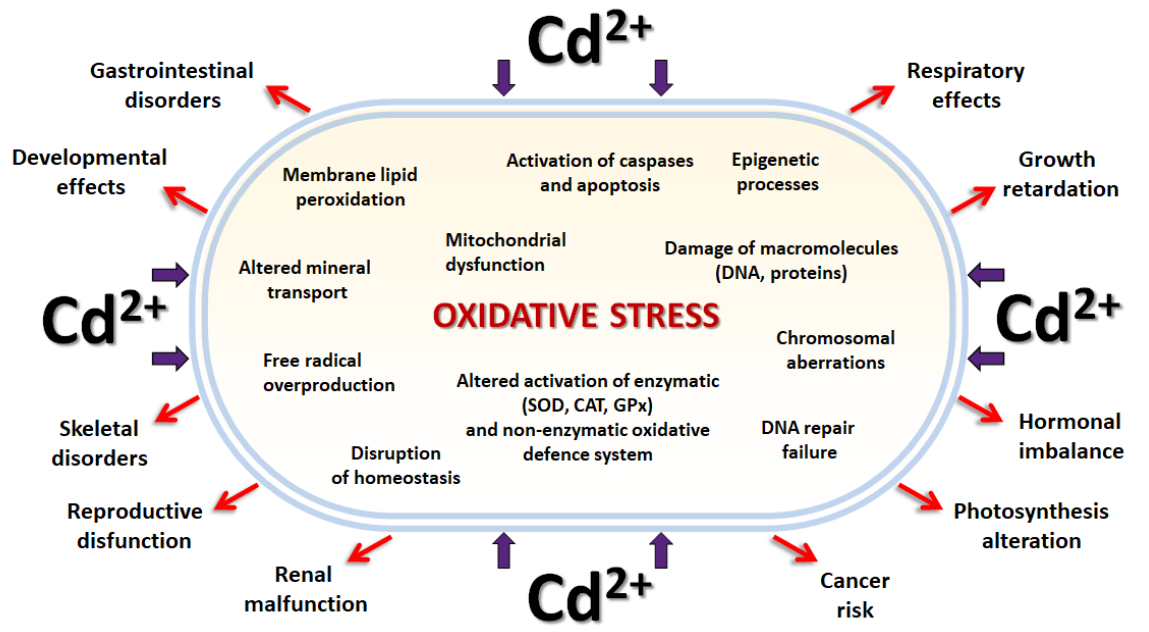
Figure 1. Cadmium toxicity. Schematic illustration of the hazardous effects of Cd toxicity on living organisms. Cd overexposure of the organism leads to severe cellular alterations predominantly due to increased production of free radicals and impaired antioxidant defense system resulting in oxidative stress consequently leading to membrane lipid peroxidation, damage of macromolecules, chromosomal aberrations, DNA repair failure, and metabolic deteriorations disrupting cellular homeostasis, activation of caspases, and apoptosis. Defects in cell function cause injury to the organism that may result in gastrointestinal disorders, developmental defects, skeletal alterations, reproductive dysfunction, renal malfunction, cancer risk, respiratory effects, growth retardation, hormonal imbalance, or altered